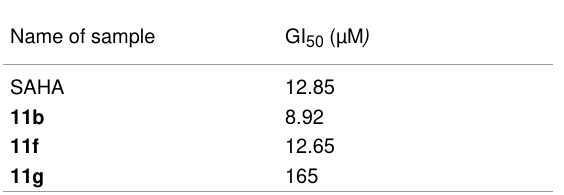
Table 2: Percent growth inhibition values a at different concentration of four compounds by MTT assay [34].